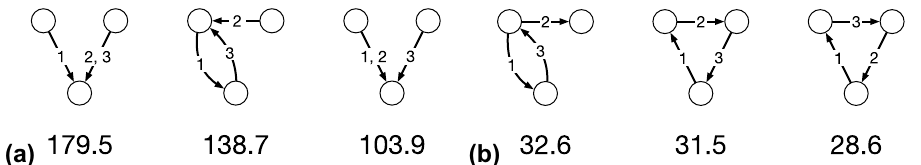
Figure 5. The three most significant ( a ) and the three least significant ( b ) 3-event motifs based on the Z score. The numbers shown are the Z scores. We used the WTS model as null model and set (cid:31) W = 10 years.